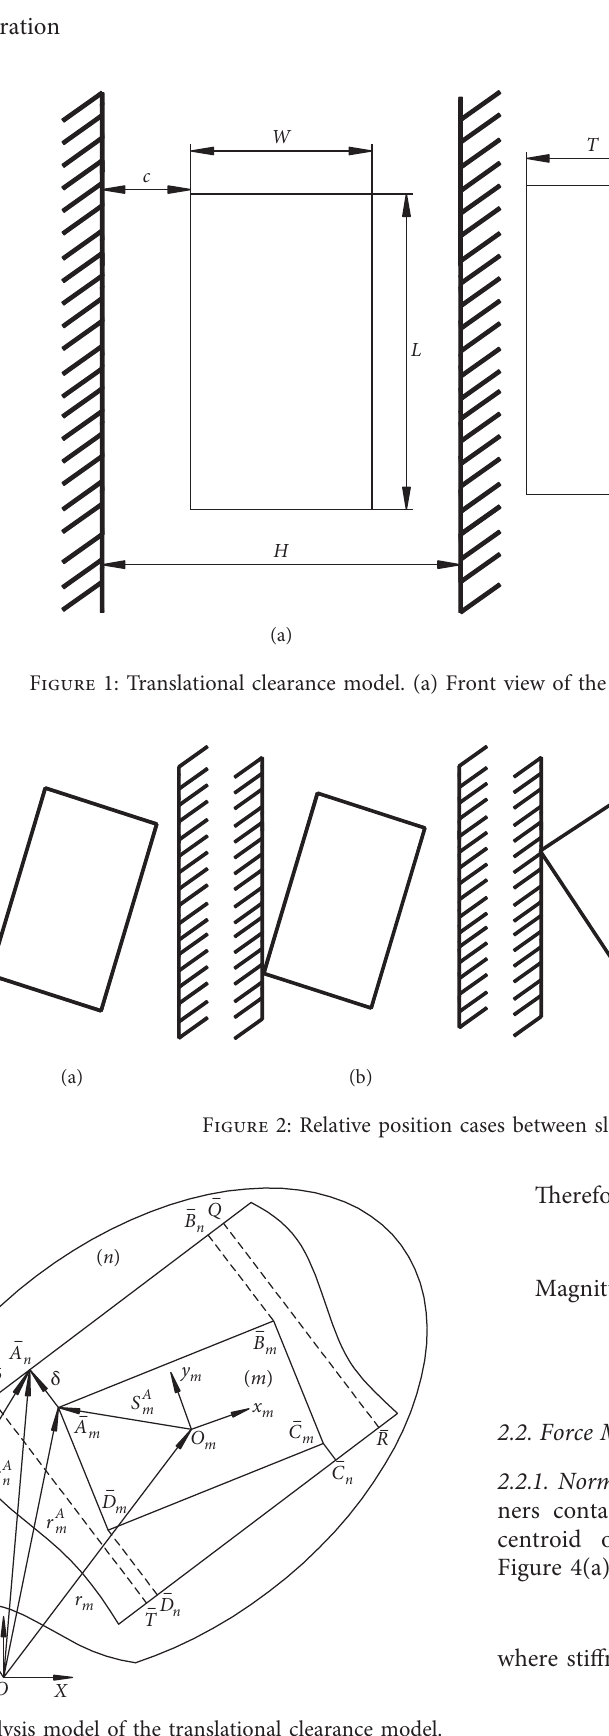
Figure 3: Analysis model of the translational clearance